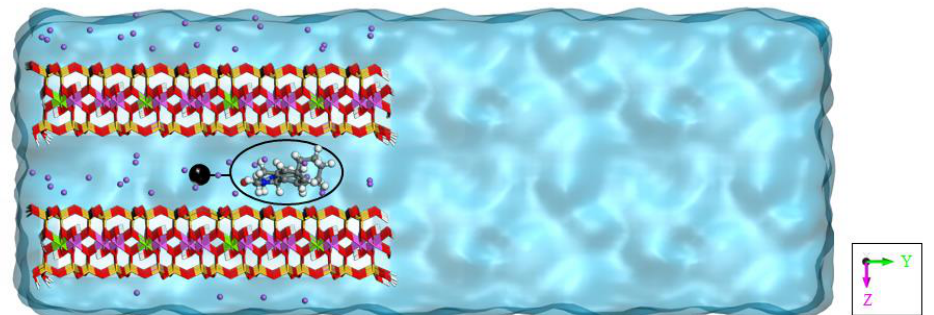
Figure 1. Model of praziquantel adsorbed on the montmorillonite surface in aqueous solution.